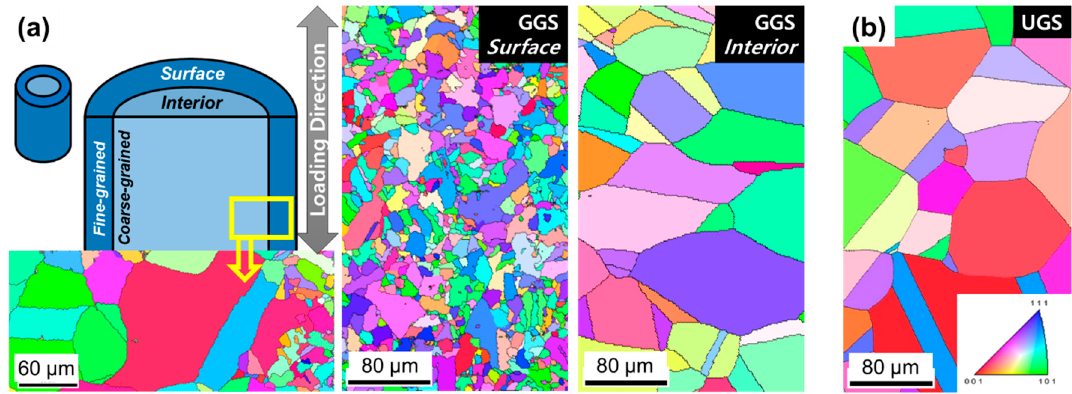
Figure 1. Electron backscatter diffraction (EBSD) inverse pole figure map of ( a ) GGS and ( b ) UGS TWIP steels. The images are perpendicular to the normal direction.